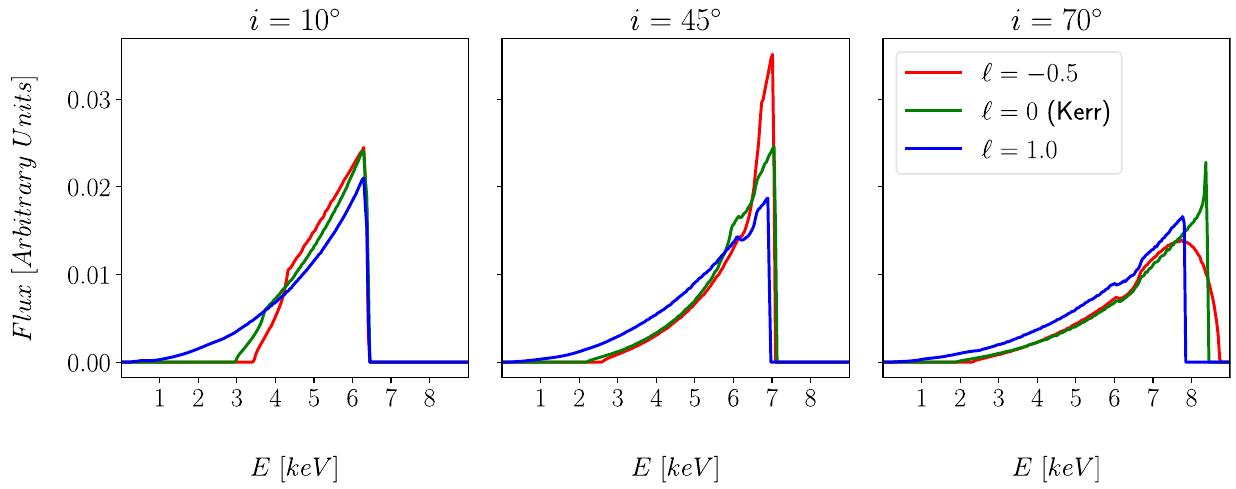
Fig. 3 Broadenedironlinesfromtheaccretiondiskaroundablackhole in bumblebee gravity with spin parameter a ∗ = 0 . 7, Lorentz-violating parameter (cid:2) = − 0 . 5 (red curves), 0 (green curves), and 1 (blue curves), and the inclination angle of the disk i = 10 ◦ (left panel), 45 ◦ (center